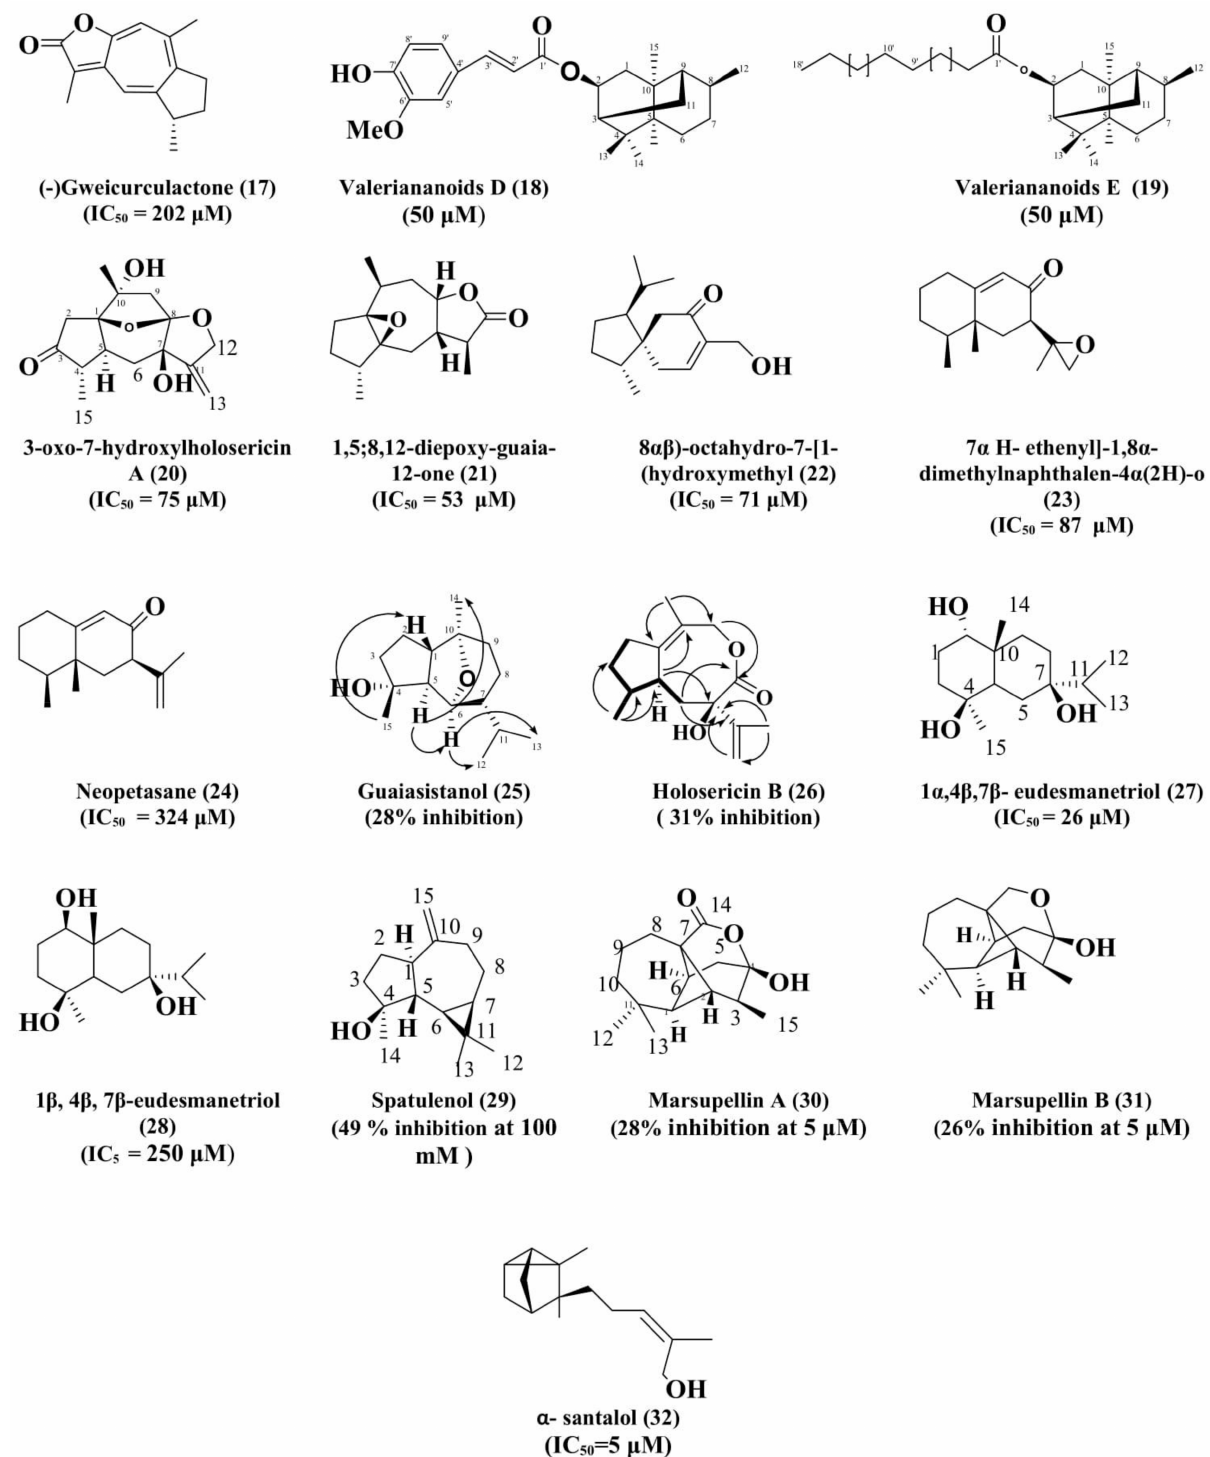
Figure 2. Various sesquiterpenoids moieties with AChE/BChE inhibitory potential. Hajimehdipooret al. [123] extracted the SLs from the Inula oculus-christi and I. aucheri- ana (Family-Compositae) and evaluated their capability of inhibiting AChE activity by using the Ellman assay method. It was observed that out of the three evaluated compounds, the Gaillardin ( 36 ) was the most versatile secondary metabolites (IC 50 for AChE 729 µ M) present in the plants and can be investigated for further AD